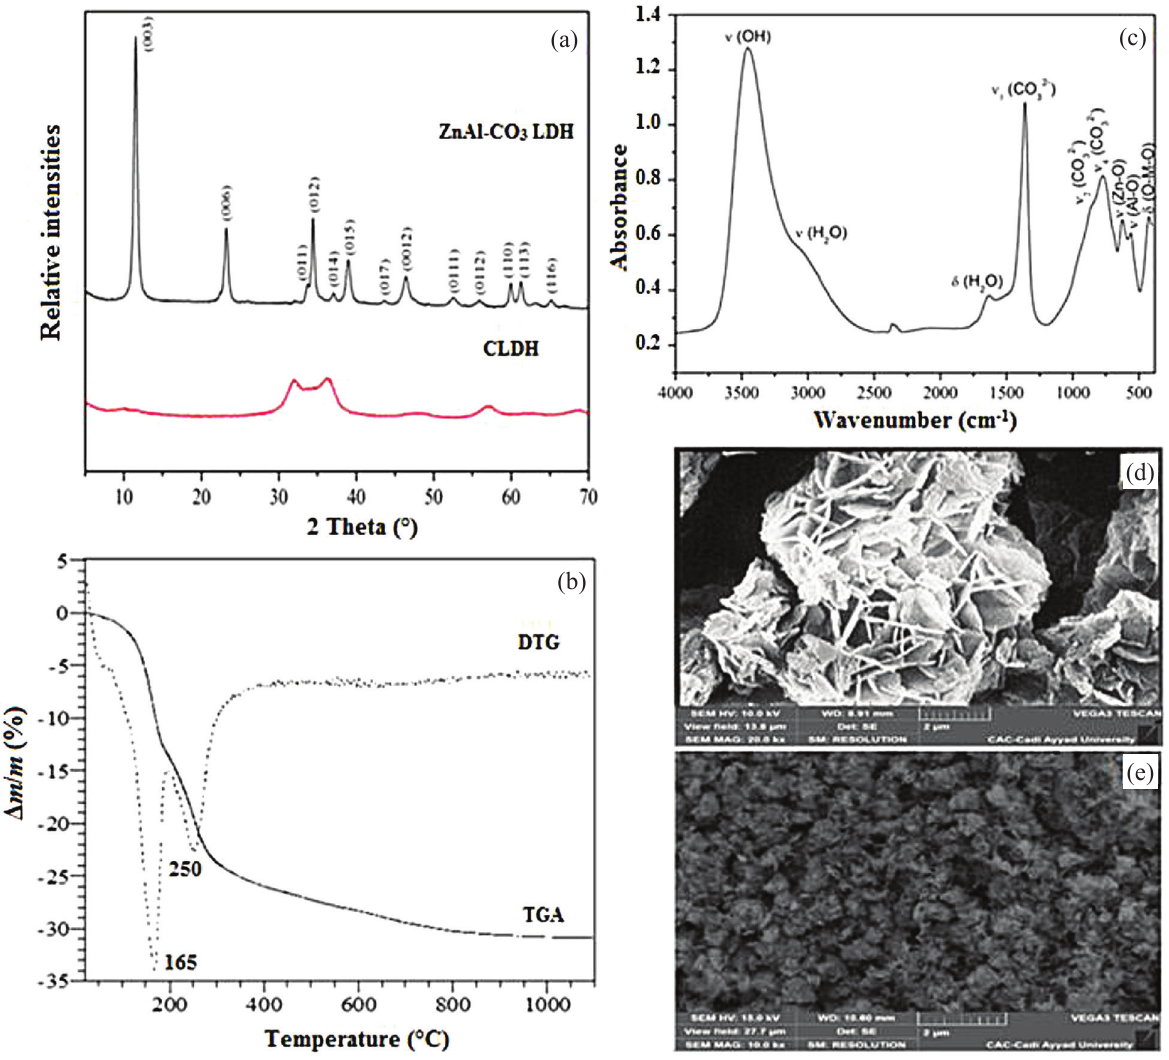
Fig. 1 – Powder XRD patterns of LDH and CLDH (a), TG-DTG curves (b), IR spectrum (c), SEM photographs of LDH (d), and CLDH